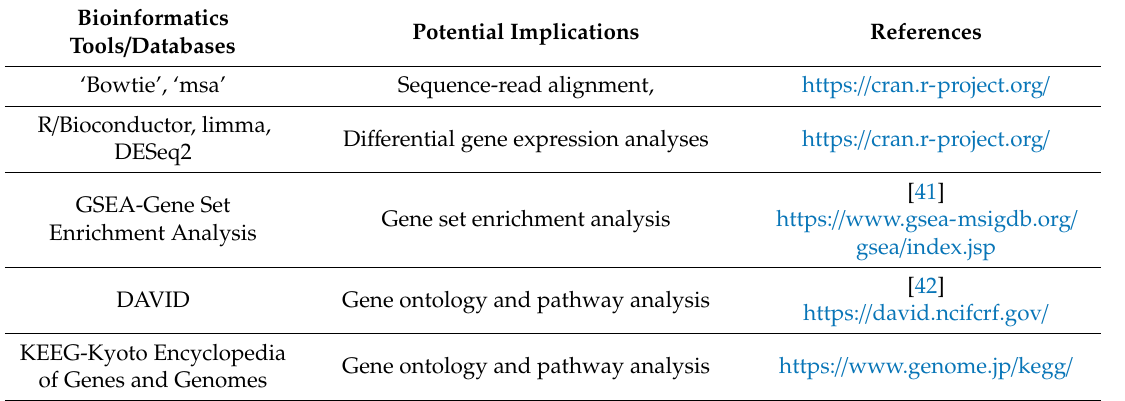
Table 1. Bioinformatic tools or database commonly used for transcriptomics or immunogenomics studies aiming to identify the key regulatory genes in